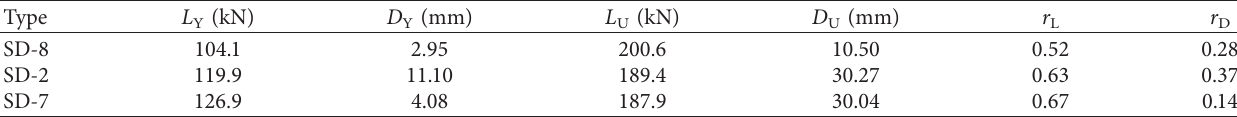
Table 3: The relevant parameters of specimens SD-8, SD-2, and